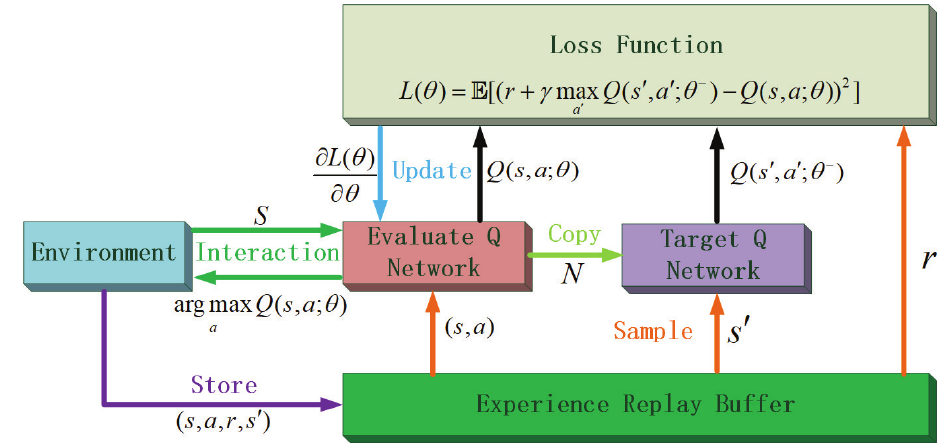
Figure 4. DQN algorithm